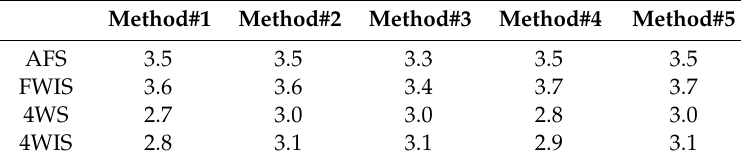
Table 4. Maximum absolute lateral o ff set error for each actuator and